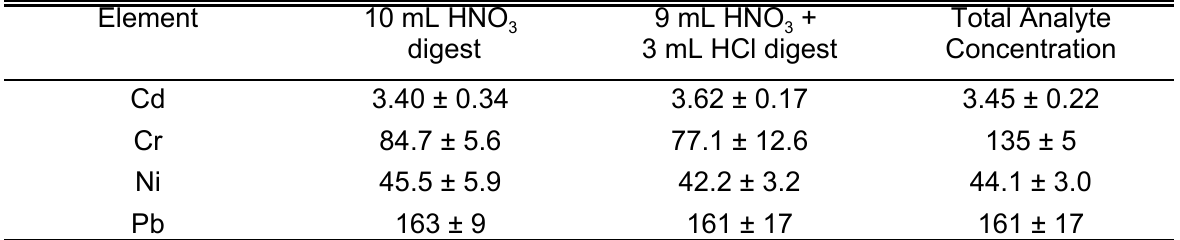
COMPARISON OF ANALYTE RECOVERIES FROM SRM 2704 (BUFFALO RIVER